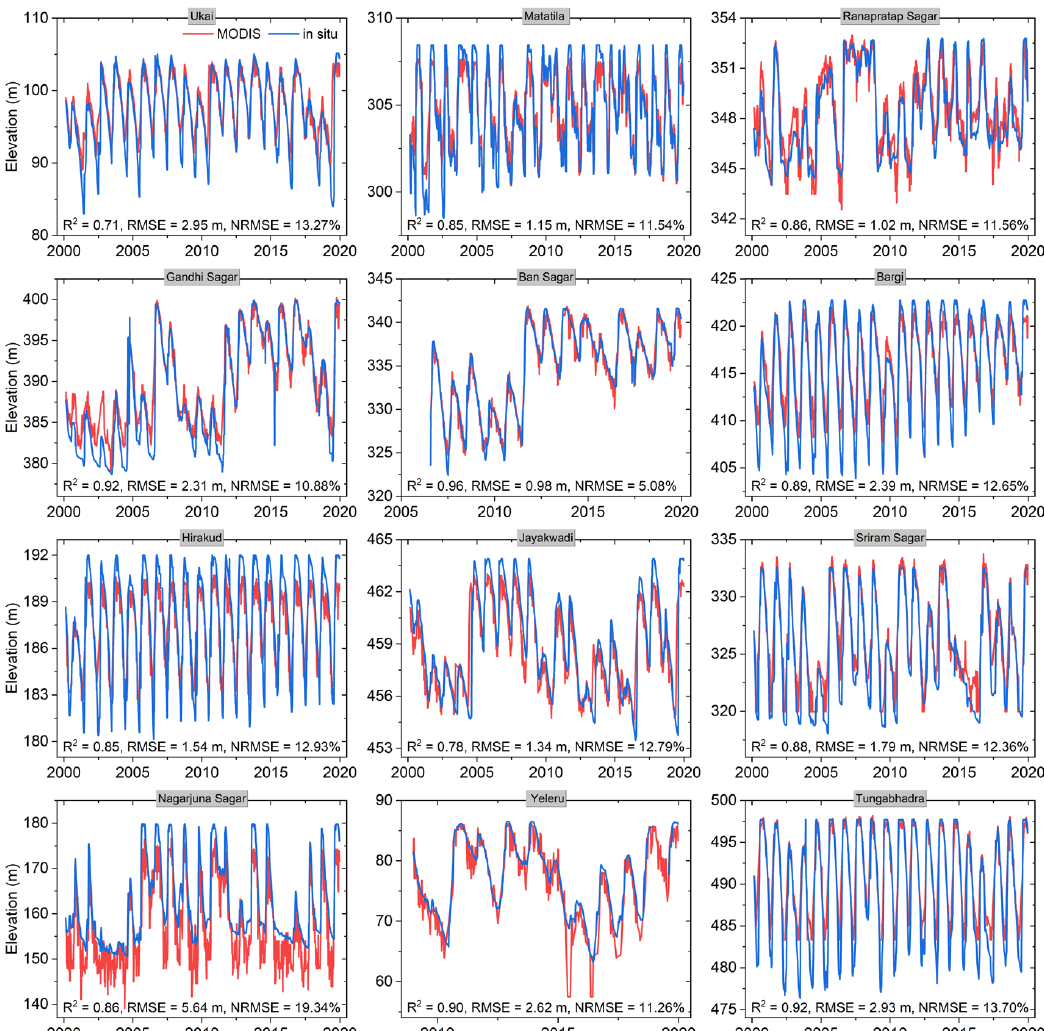
Figure 6. Validation of MODIS 8-day elevation products for twelve Indian reservoirs from 2000 to 2019. Next, we validated the monthly elevation and storage products over these twelve Indian reservoirs. The daily in situ elevation and storage values were averaged at a monthly step and were then compared to the monthly MODIS products (Figures A1 and A2). The validation results show similar patterns as those of the 8-day products but higher accuracies. This is because the monthly reservoir area values were generated from the composited results of three or four 8-day reservoir areas from MxD28C2, and the composition process further reduced the adverse effects of cloud contamination at the 8- day time step. As shown in Figure A1, the MODIS-based elevations show good consistency with the in situ measured data, with an average R 2 value of 0.90, an average RMSE value of 1.99 m, and an average NRMSE value of 11.33%. Regarding the storage validations (Figure A2), the results are consistent with those of the elevations, with an average R 2 value of 0.91, an average RMSE value of 0.43 km 3 , and an average NRMSE value of 11.91%.